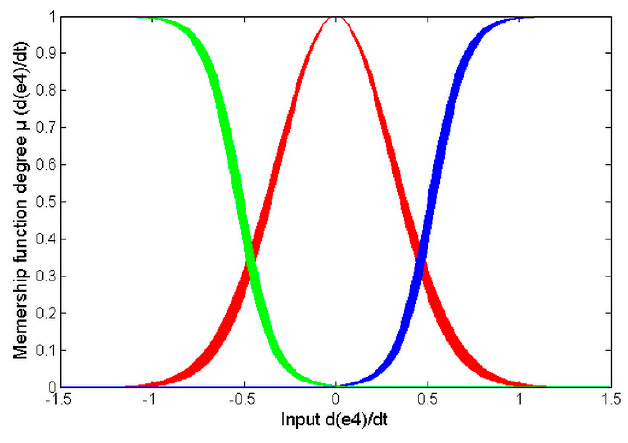
e  and 3 e  . 2 . . e 2 and e 3 .